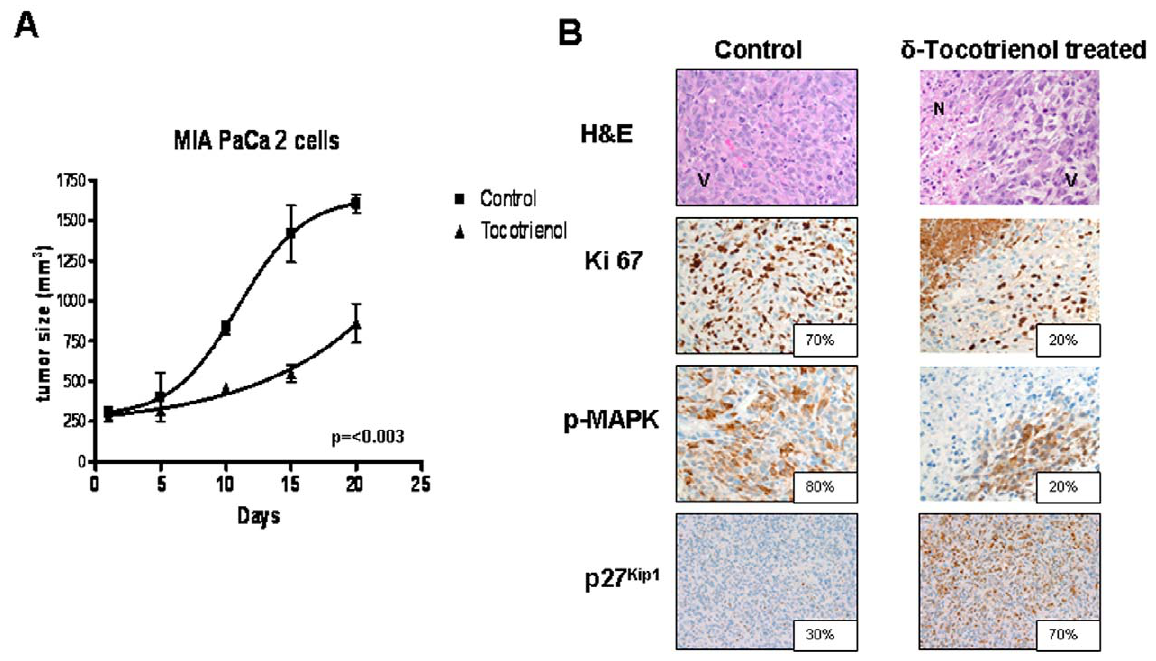
Figure 5. d -Tocotrienol suppresses pancreatic tumor growth in nude mice. A, nu/nu mice were injected subcutaneously with a suspension of MIAPaCa-2 cells (1 6 10 6 ) combined with Matrigel in both flanks. Tumor volume was recorded every other day according to the formula V = ( l + w )/ 2 6 ( l 6 w ) 6 0.5236, where l is length and w is width. Tumors with equal growth rates and initial volumes between 250 and 300 mm 3 were then randomized to receive d -tocotrienol (100 mg/kg) or vehicle (purified olive oil) daily by gavage. Data showing significant inhibition of tumor growth by d -tocotrienol are representative of 5 tumors/treatment group repeated on 3 separate occasions ( P , 0.003). B, tissue sections from tumors were fixed in paraformaldehyde and embedded in paraffin for immunohistochemical staining of Ki67, MAP kinase, and p27 Kip1 . Representative sections are shown. Areas of tumor necrosis (N) were consistently visualized in the d -tocotrienol group in contrast to the vehicle group where only viable (V) tumor was present. H&E, hematoxylin and eosin. Numbers represent percentage of positive cells. H&E and immunohistochemistry,